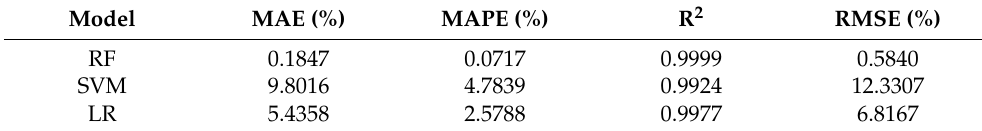
Table 5. Performance indicators of different models.